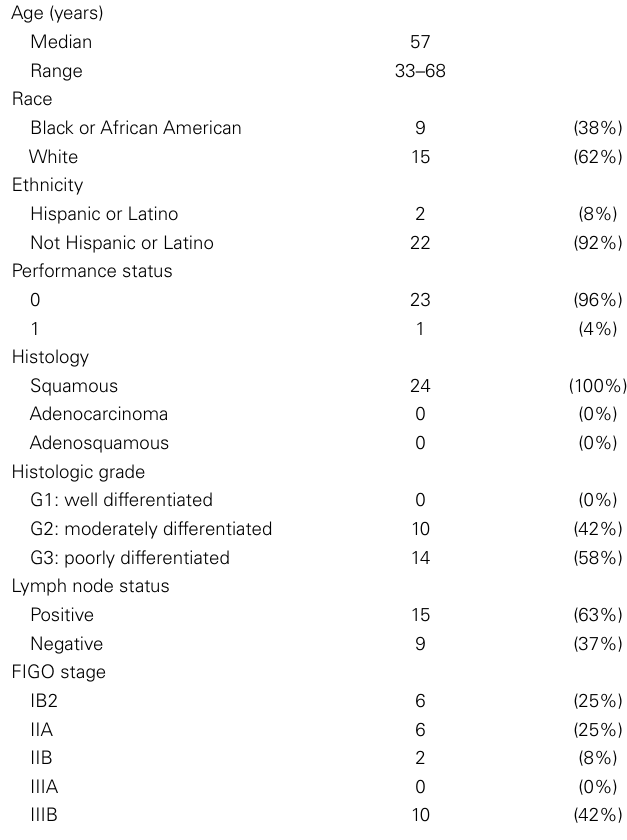
FIGO, international federation of gynecology and